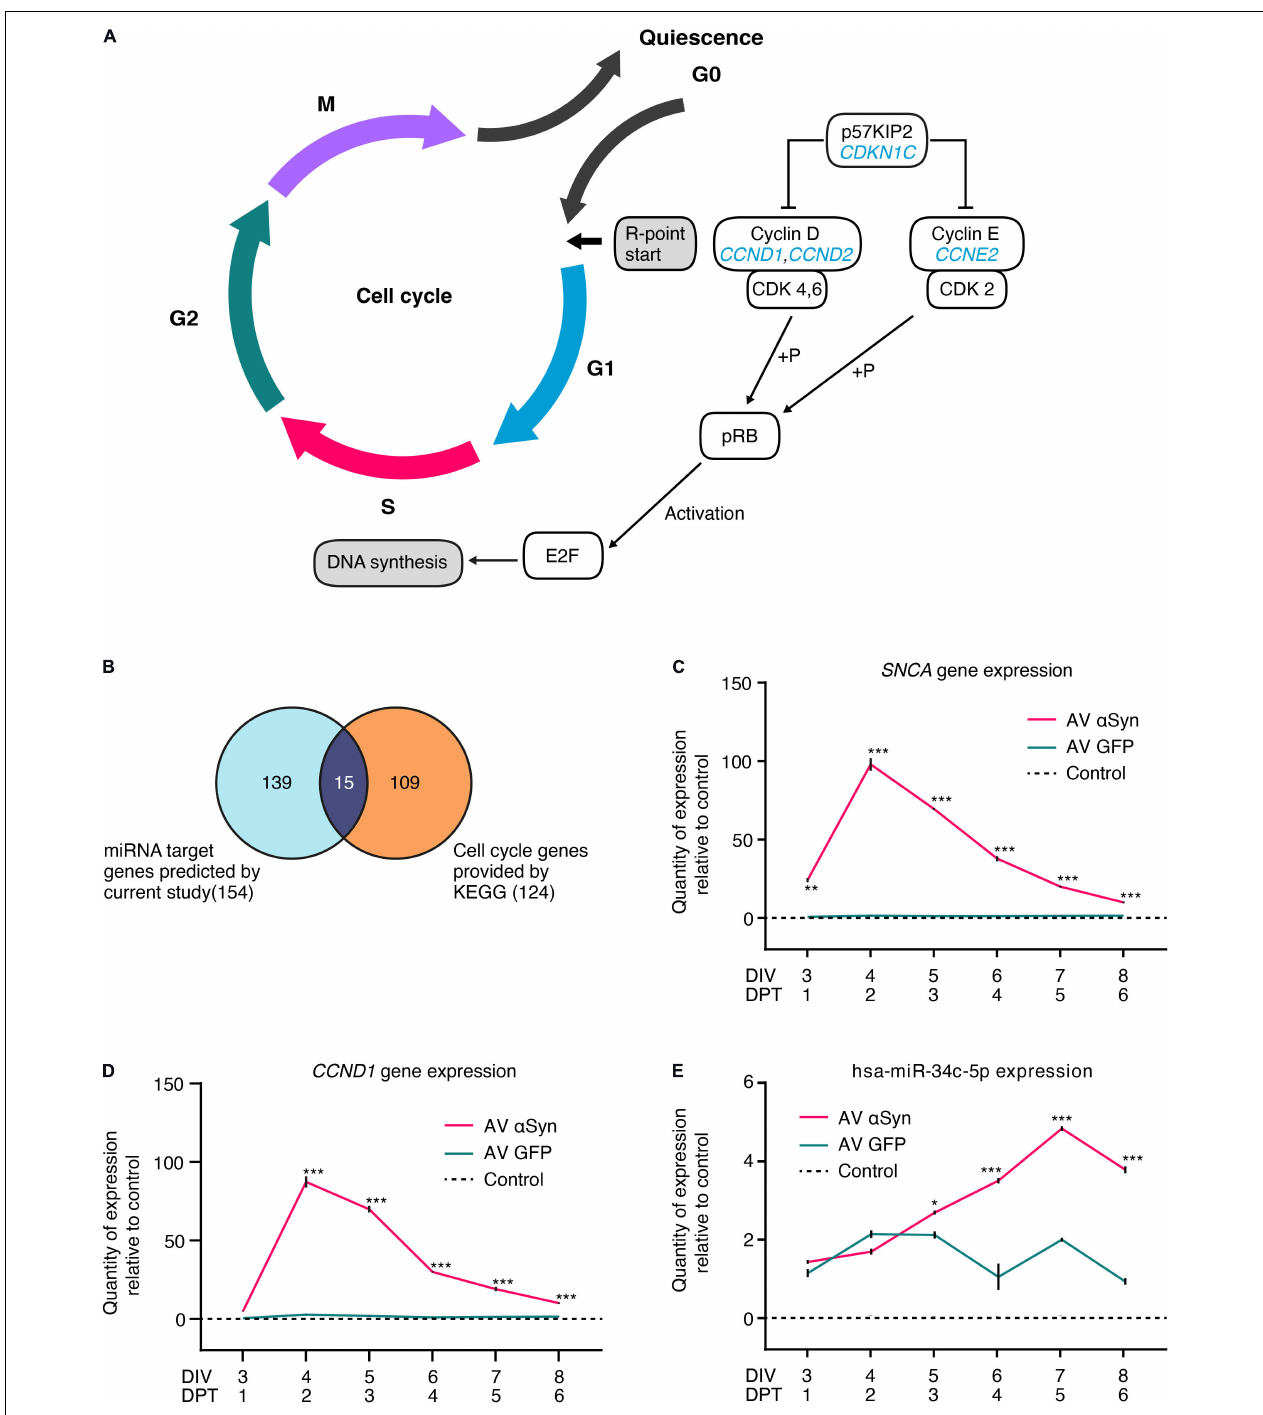
FIGURE 4 | Cell cycle as most significantly altered process. (A) Simplified illustration of the mitotic cell cycle phases. Encoded proteins of the genes CCND1 , CCND2 , CCNE2 , and CDKN1C (labeled in blue) from the most significantly enriched process after PANTHER GO-Slim pathway analysis are key players for the transition of the cell from quiescence to initiation of G1 cell cycle phase. (B) Overlap of 154 target genes predicted by current study and 124 KEGG (Kyoto Encyclopedia of Genes and Genomes) cell cycle genes identified 15 SNCA overexpression-affected cell cycle genes. Gene expression of SNCA (C) , CCND1 (D) , and hsa-miR-34c-5p (E) measured over time by qRT-PCR in LUHMES neurons transduced with adenoviral (AV) vectors of SNCA or GFP (control virus) or non-transduced (control). Values are related to non-transduced control at the corresponding times set as one. Values in panels (C–E) are mean ± SEM from at least three biological repeats. Statistical analysis was performed by a two-way ANOVA with Sidak’s correction for multiple comparison testing and, if significant, pairwise comparisons were evaluated by an unpaired t -test. * P < 0.05, ** P < 0.01, *** P < 0.001 vs. GFP virus control in panels (C–E) ; DIV, days in vitro ; DPT, days post transduction.